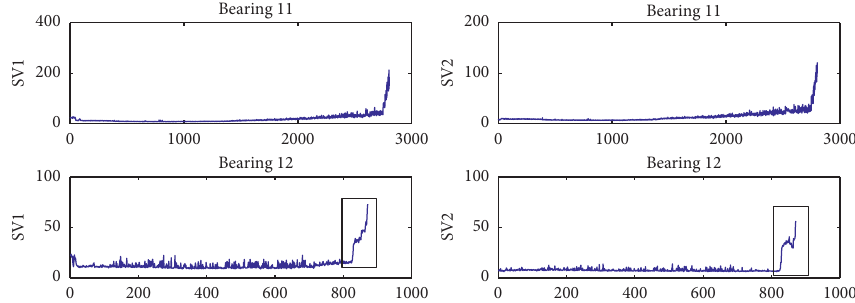
Figure 24: SV features extracted for bearings 11 and 12 from the first two IMFs by using SVD.